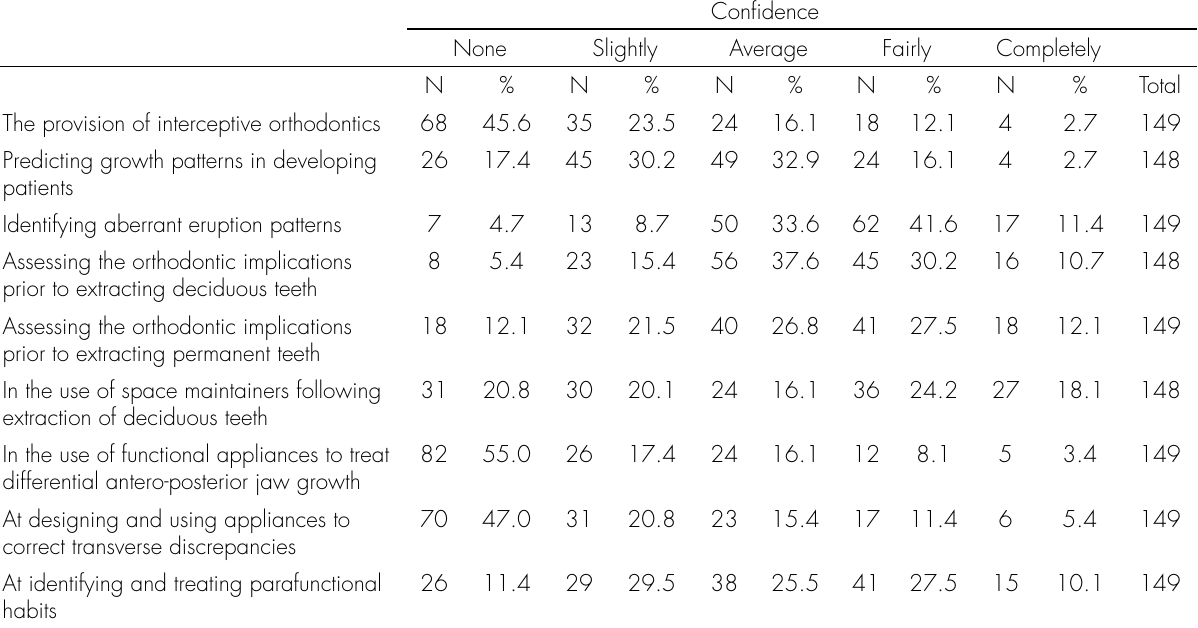
Table II. General dentists’ confidence in interceptive orthodontic practice.